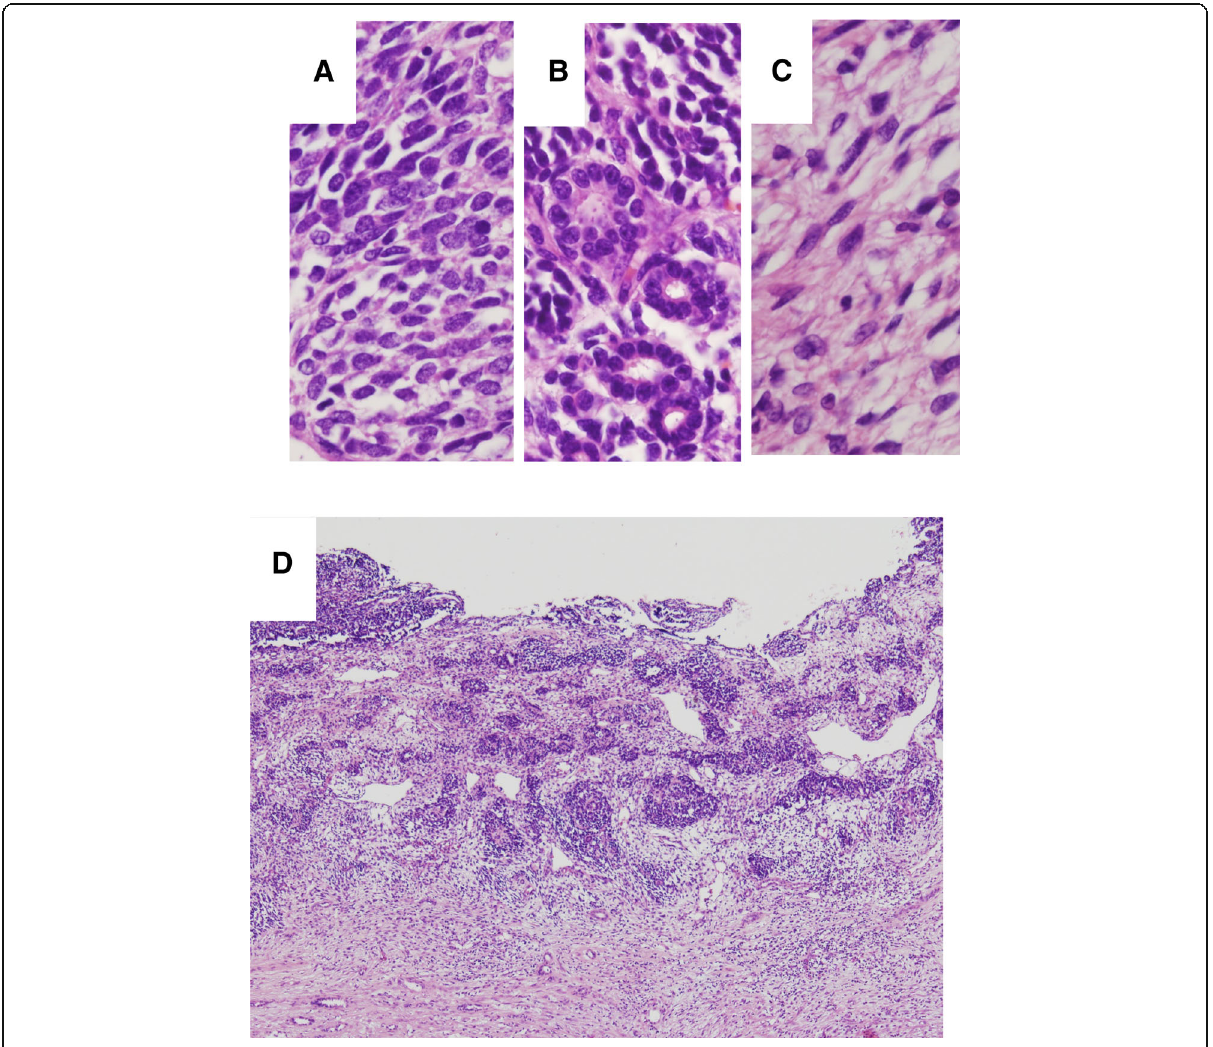
Fig. 4 Histological findings of the tumor. a Blastemal cells (H&E staining, ×400). b Epithelial cells (H&E staining, ×400). c Stromal cells (H&E staining, ×400). c Low-powered view of cystic wall of the tumor (H&E staining,